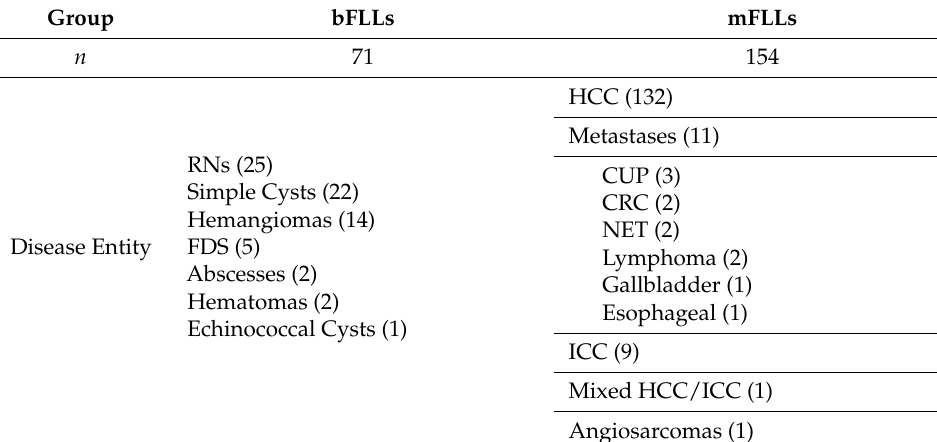
Figure 1. The exclusion and diagnostic confirmation diagram. LC, liver cirrhosis; FLL, focal liver lesion; mFLL, malignant focal liver lesion; bFLL, benign focal liver lesion; HCC, hepatocellular carcinoma; CT, computer tomography; MRI, magnetic resonance imaging; US, ultrasound; CEUS, contrast enhanced ultrasound; FU, follow-up. Table 1. The final diagnoses of all 225 FLLs.